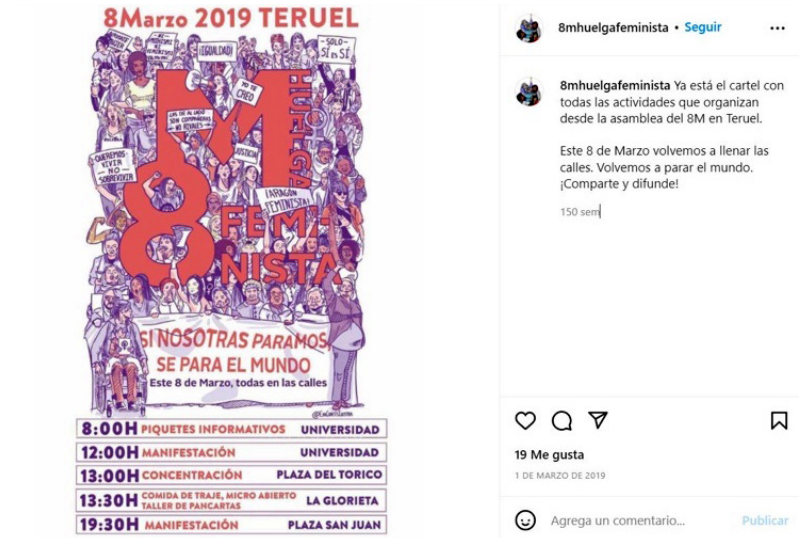
Figure 2. Example of an Instagram post disseminating offline actions. Notes: text in English—“The poster with all the activ‐ ities organized since the 8M assembly in Teruel. This March 8 we fill the streets again. We are back to stop the world. Share and spread!” Source: 8mhuelgafeminista